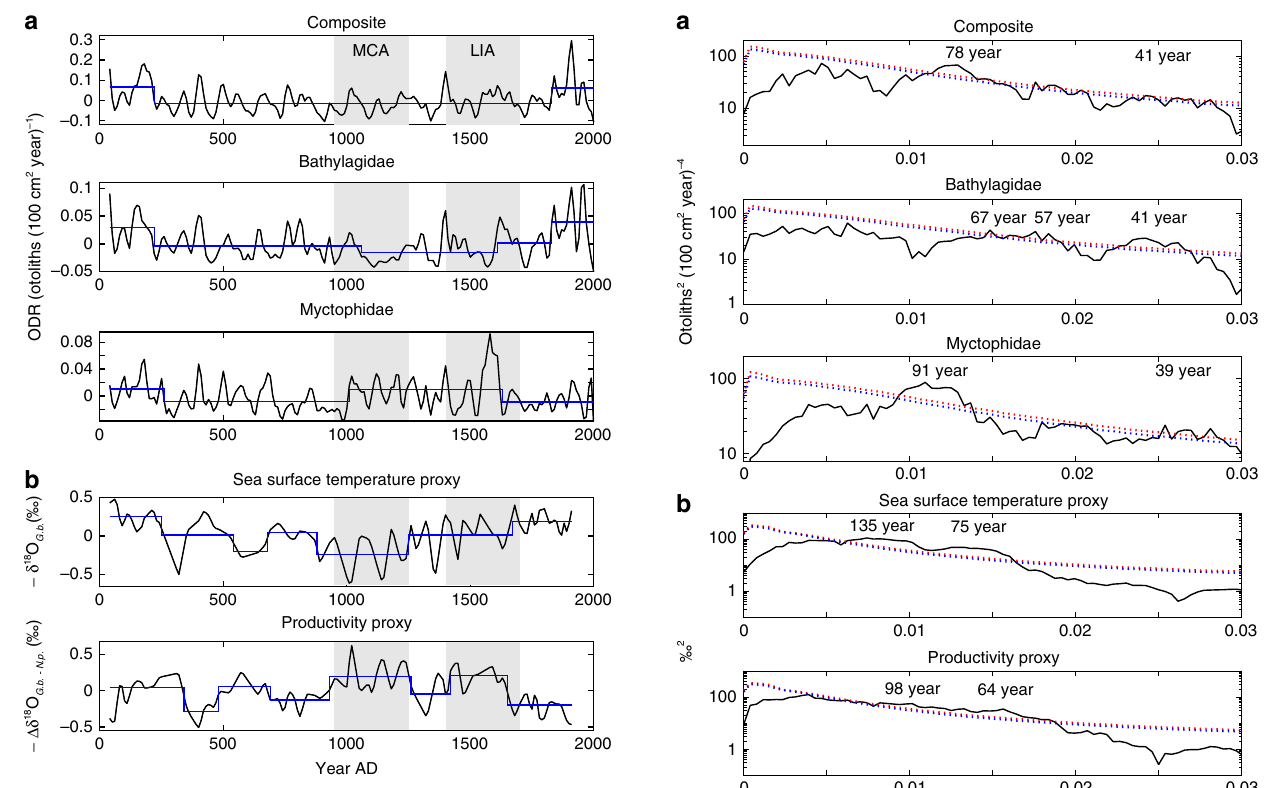
and their time series were dome-shaped over the two millennia, with SST minimal and PROD maximal ~1000 A.D. (Fig. 3).